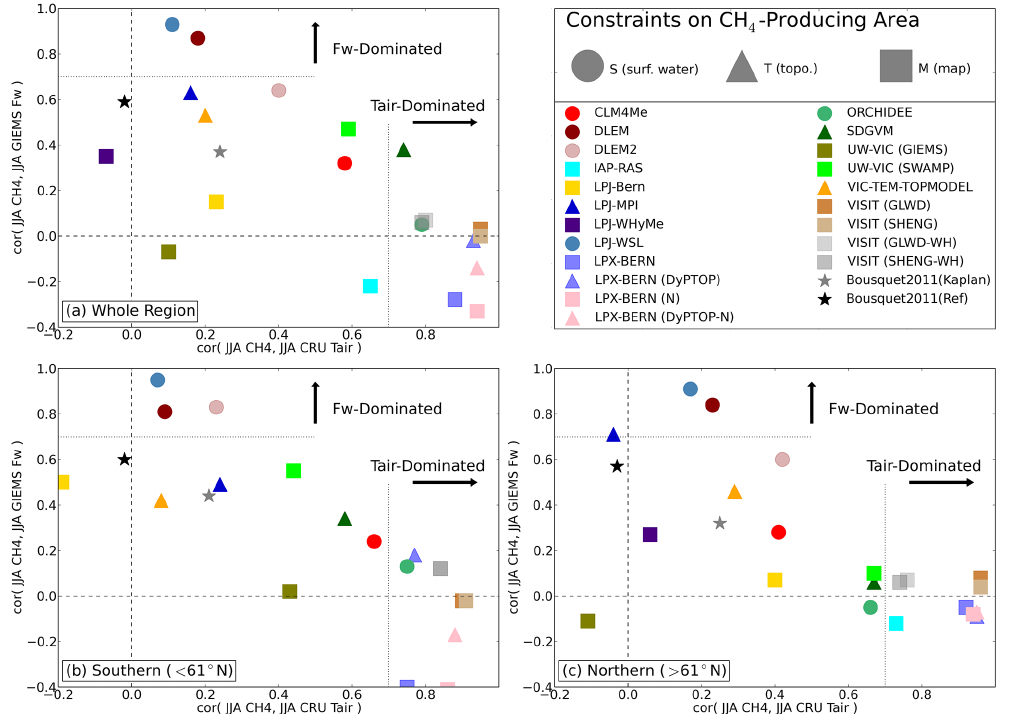
Figure 12. Influence of interannual variations in surface water area fraction ( F w ) on model CH 4 emissions (expressed as correlation between JJA GIEMS F w and JJA CH 4 ) vs. influence of air temperature ( T air ) on model CH 4 emissions (expressed as correlation between JJA CRU T air and JJA CH 4 ), for the entire WSL (top) and the southern and northern halves of the domain (bottom). F w -Dominated and T air -Dominated denote correlation thresholds above which surface water area or air temperature, respectively, explain more than 50% of the variance in CH 4 emissions. Circles denote models that used satellite surface water products alone (corresponding to code S in Table 2) to delineate wetlands. Triangles denote models that used topographic information, with or without surface water products (corresponding to code T in Table 2). Squares denote models that used wetland maps with or without topography or surface water products (corresponding to code M in Table